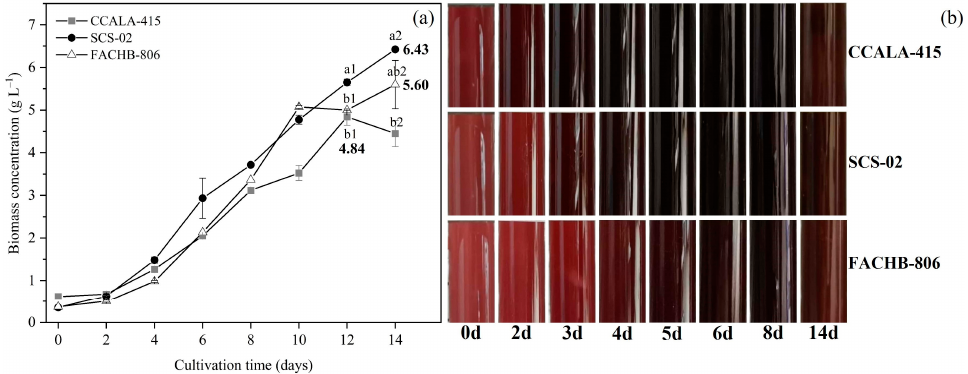
Figure 2. Growth characteristics of Porphyridium cruentum CCALA-415, Porphyridium purpureum SCS-02 and Porphyridium purpureum FACHB-806. ( a ) Biomass concentration from day 0 to day 14; ( b ) The color change of the culture in the photobioreactors as a function of time. The values shown in the three strains of Porphyridium (a1–c1: day 12; a2–c2: day 14) (level of significance, p < 0.05).